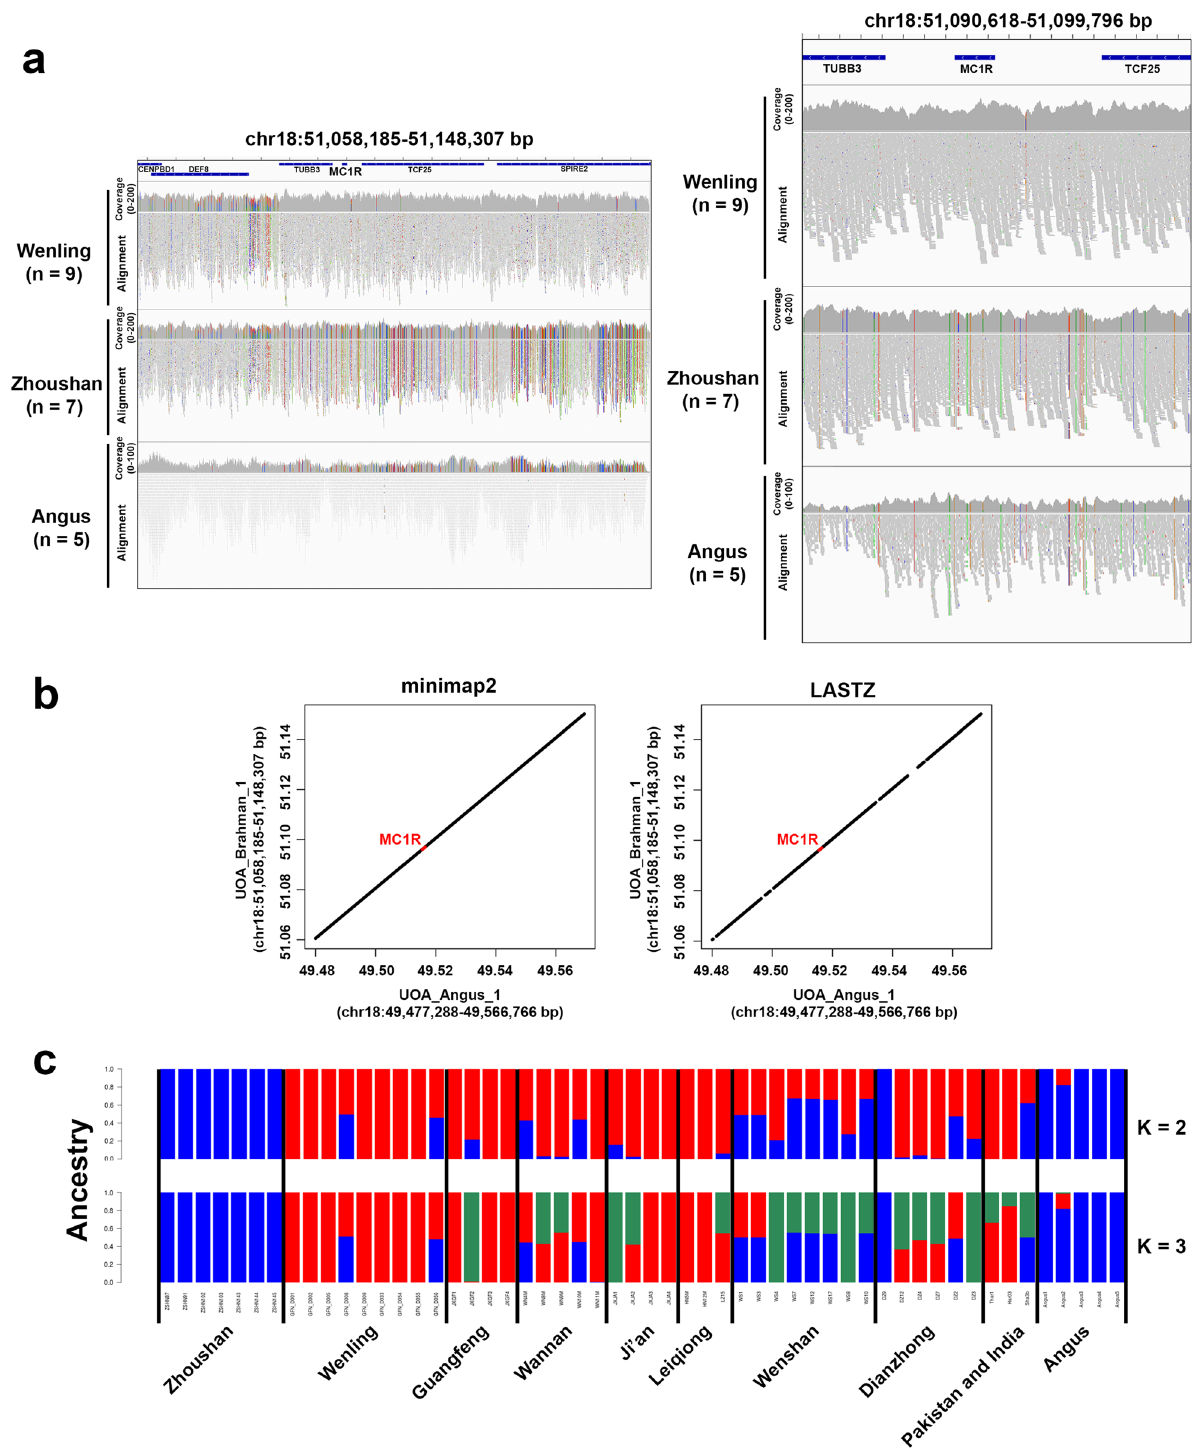
Figure 5. Read depth distribution, genome alignment and admixture analysis of the MC1R region. ( a ) Read depth distributions in the MC1R region. The left panel shows the read depth distributions in the region from 51,058,185 to 51,148,307 bp on chromosome 18. The right panel shows the read depth distributions in the region from 51,090,618 to 51,099,796 bp on chromosome 18. For each breed, the sequencing reads were integrated. The first track represents read depth distribution in each breed, and the second track represents read alignments to the reference genome. For a given base position, if the base call in the sequencing read and the corresponding base in the reference genome are different, adenine is shown in green, thymine in red, guanine in orange, and cytosine in blue. ( b ) Dot plots showing the genome alignments of the MC1R regions of the UOA_Angus_1 assembly (chr18:49,477,288–49,566,766 bp) and the UOA_Brahman_1 assembly (chr18:51,058,185–51,148,307 bp). The left panel shows the genome alignment by minimap2 aligner and the right one shows the genome alignment by LASTZ aligner. The region corresponding to the MC1R gene body is highlighted in red. ( c ) Admixture analysis of the MC1R region. The SNPs located in the MC1R region (chr18:51,058,185–51,148,307 bp) were collected and subjected to admixture analysis. The order of the samples is the same as in Fig.